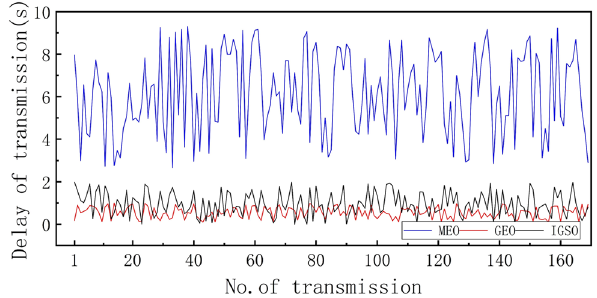
Figure 7: Transmission delay of the MEO, GEO, and